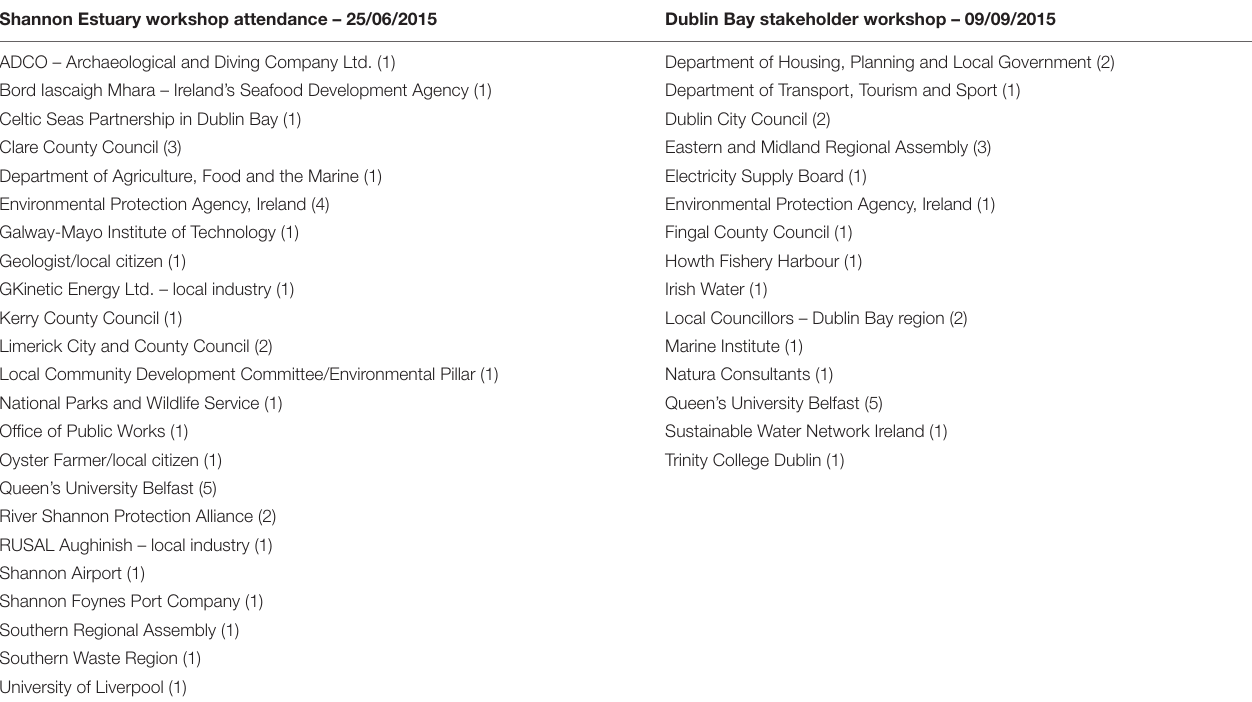
TABLE 1 | Summary of workshop attendees by organisation (number of participants in